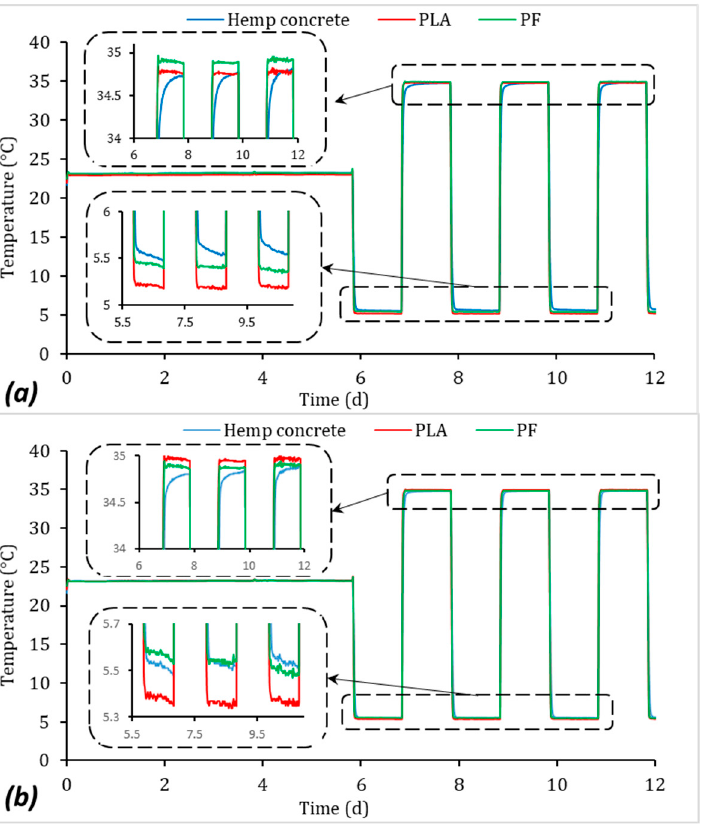
Figure 13. Temperature evolution within the studied samples (infill 10%) at a depth of ( a ) 2.5 cm and ( b ) 5 cm.